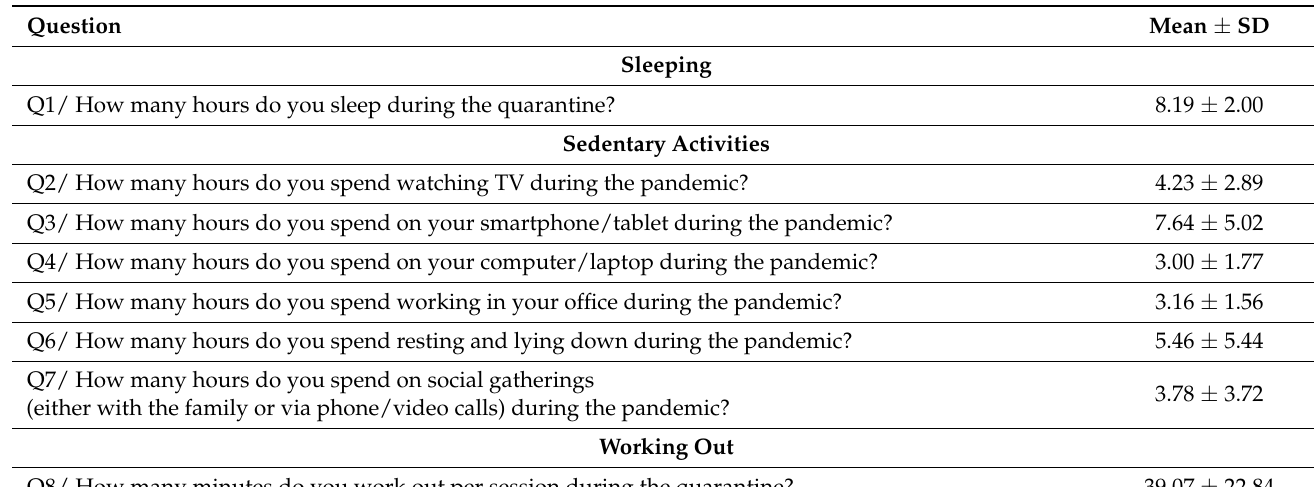
Table 5. Time spent on sleeping, sedentary activities, and working out ( n = 786).